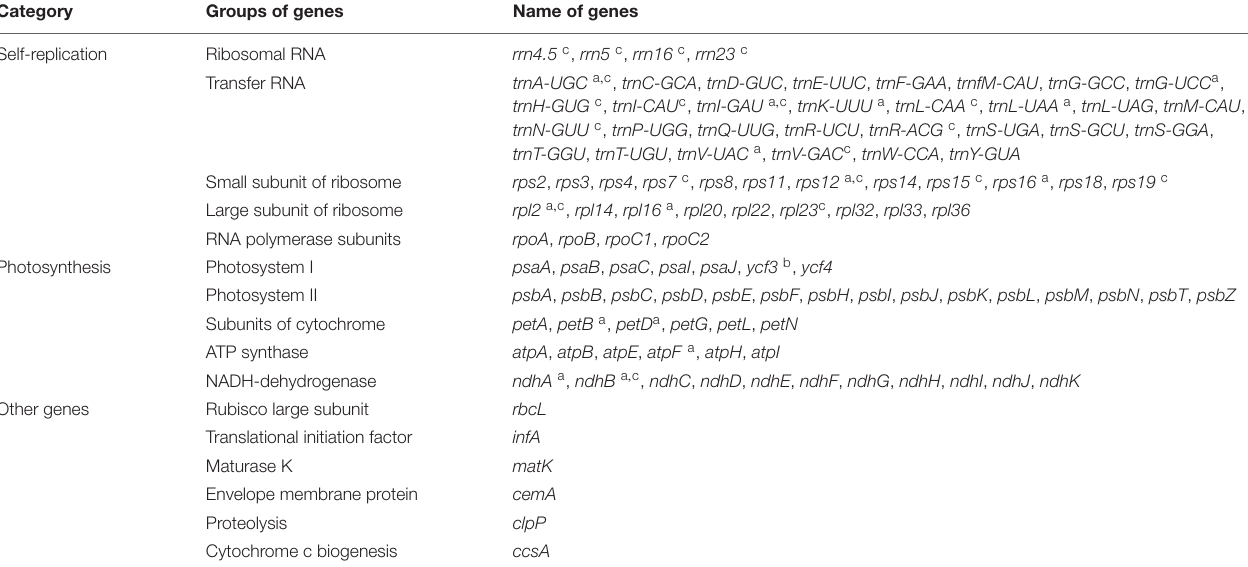
TABLE 2 | List of the annotated genes in the chloroplast genomes of C. subtilis .